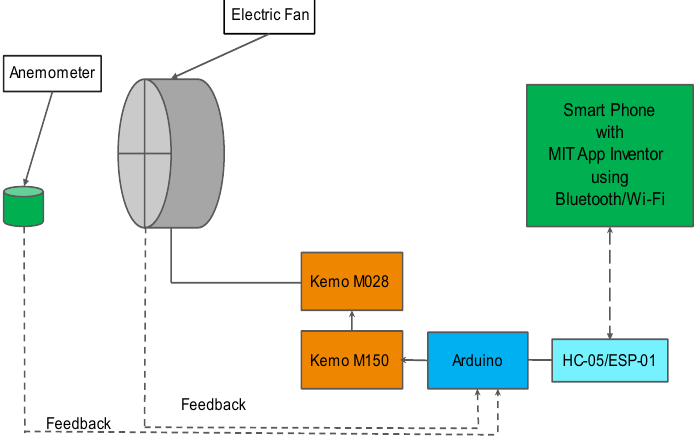
Figure 1. Design overview of the basic version of the computerized airflow system.